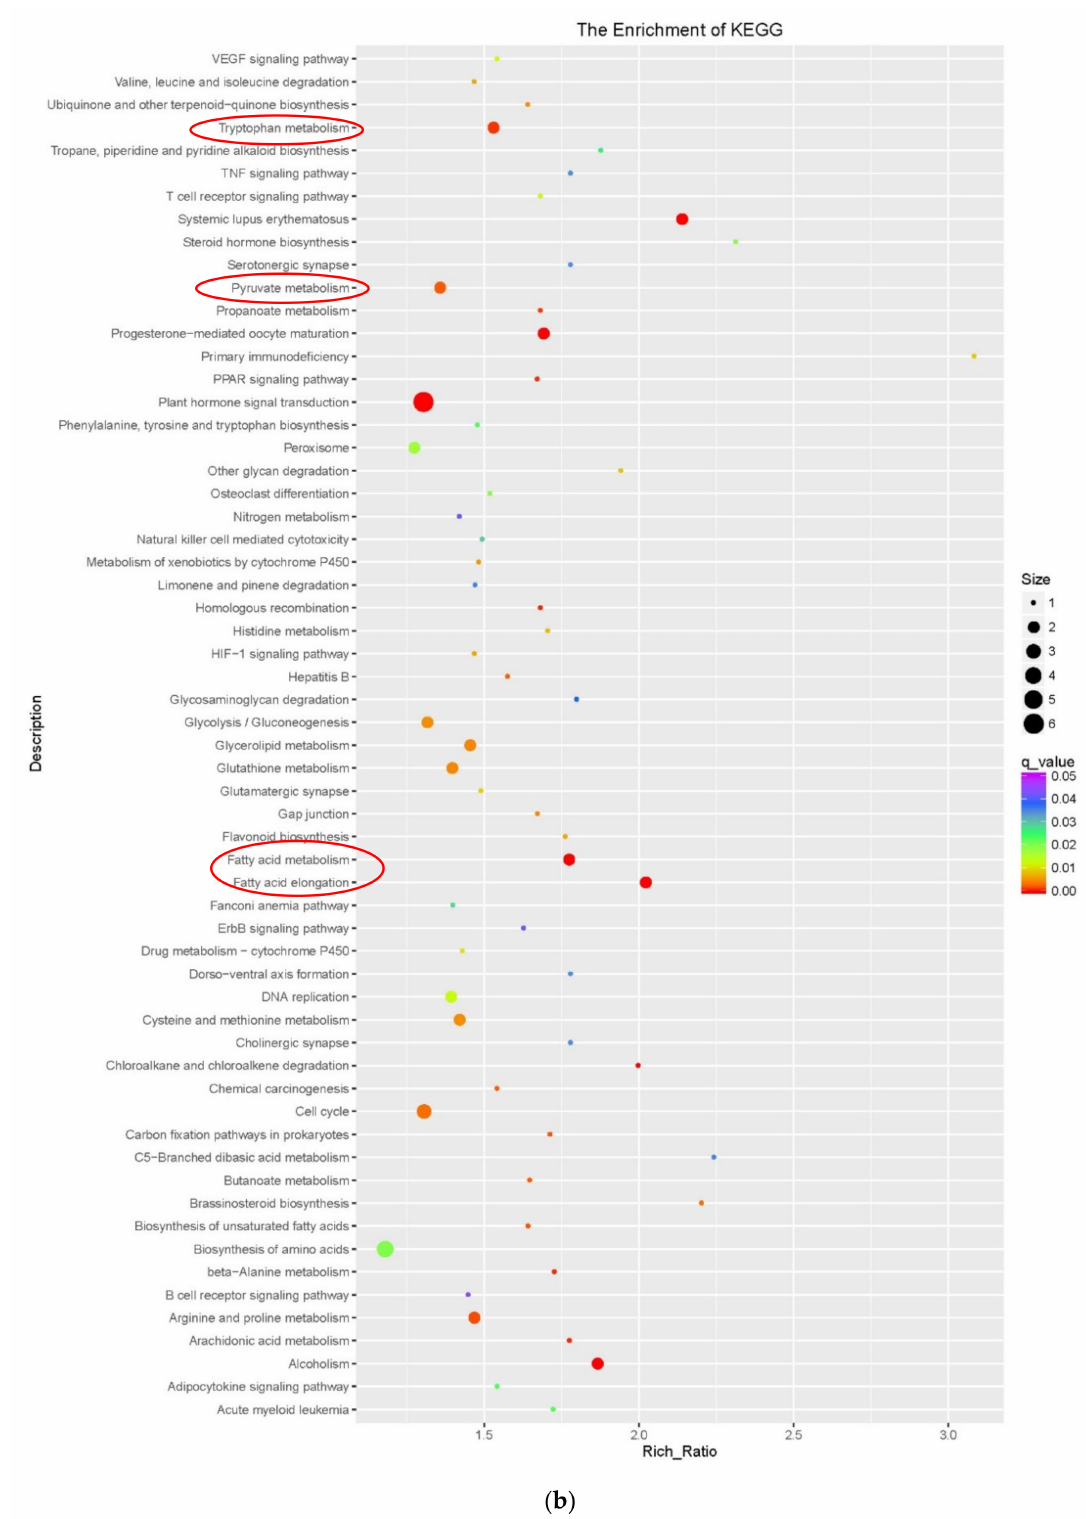
Figure A1. Functional KEGG enrichment analysis of di ff erentially expressed genes during embryogenic transdi ff erentiation in the two genotypes. ( a ) KEGG enrichment of DEGs in LM_PEC compared to LM_NEC; ( b ) KEGG enrichment of DEGs in YZ_PEC compared to YZ_NEC. The KEGG pathway with a false-discovery rate adjusted p-value < 0.05 are shown. KEGG, Kyoto Encyclopedia of Genes and